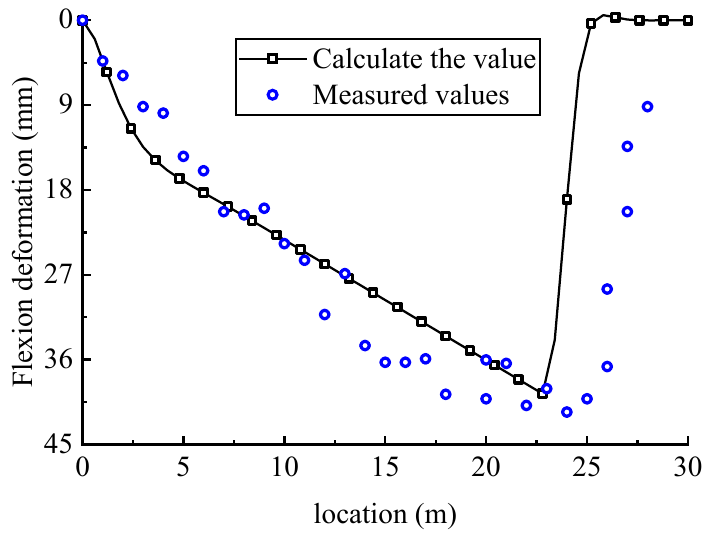
Figure 3. Comparison between the calculated value and the measured value of pipe roof deformation.